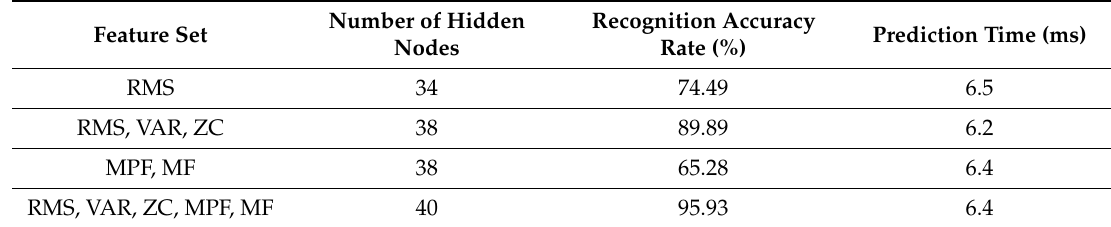
Table 2. Recognition accuracy of di ff erent feature parameter sets in a three-layer multilayer perceptron model. Root mean square (RMS), variance (VAR), zero crossing (ZC), mean power frequency (MPF), and median frequency